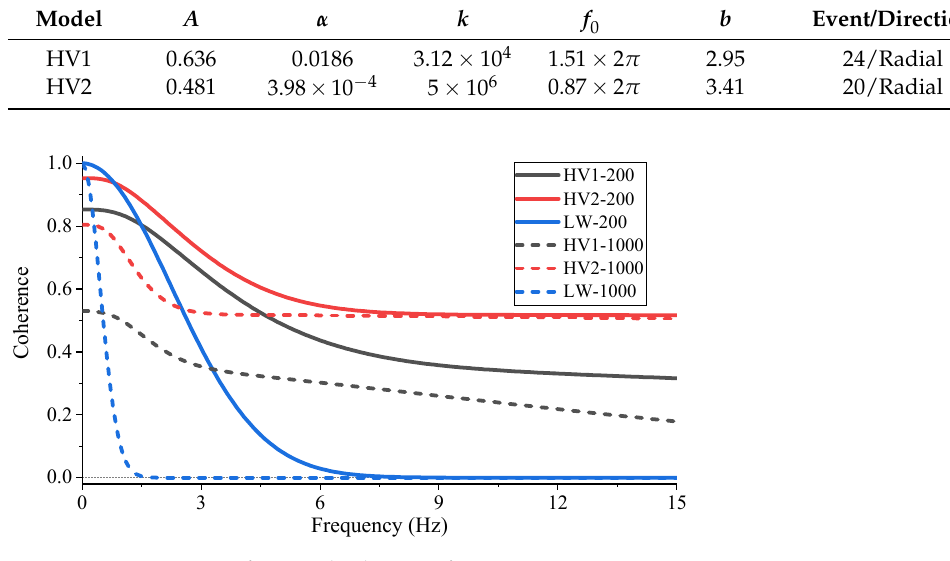
Figure 3. Comparison of spectral coherence functions. A ground-motion time series can be represented by the Fourier series expansion in Equation (4).